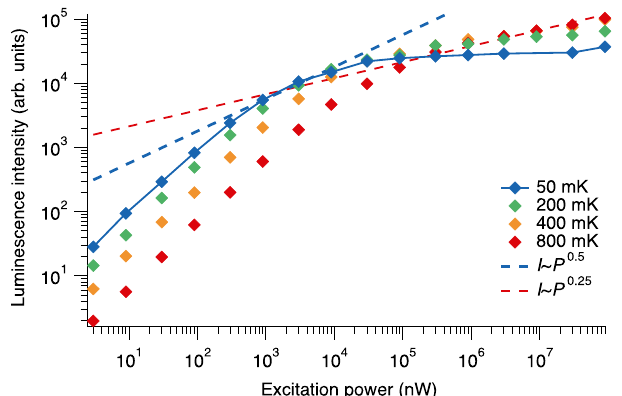
Fig. 2 | Luminescence intensity of trapped 1 s paraexcitons as a function of excitation power at varying temperatures of the mixing chamber. The dashed blue (red) line shows the excitation power dependence proportional to the 0.5th (0.25th) power of the